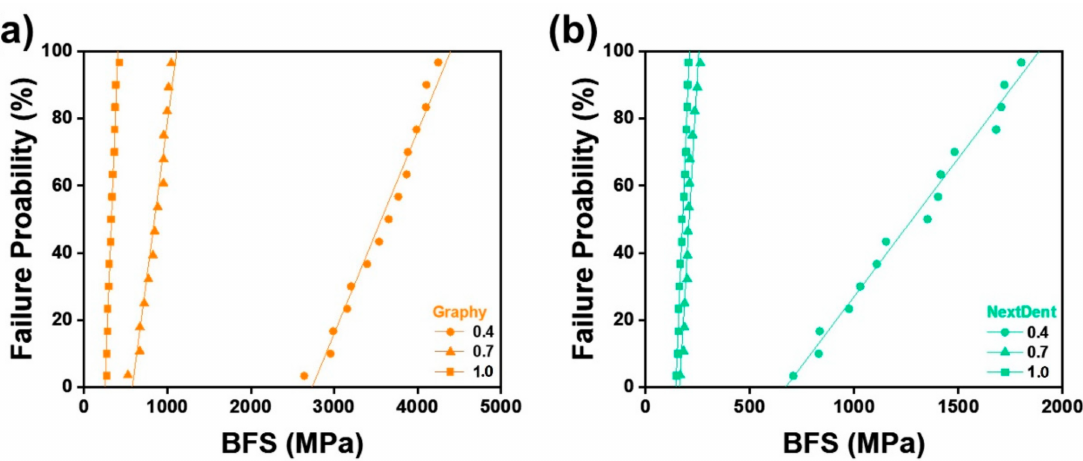
Figure 5. Failure probability according to Weibull analysis of biaxial flexural strength (BFS): ( a ) Graphy, ( b ) NextDent.